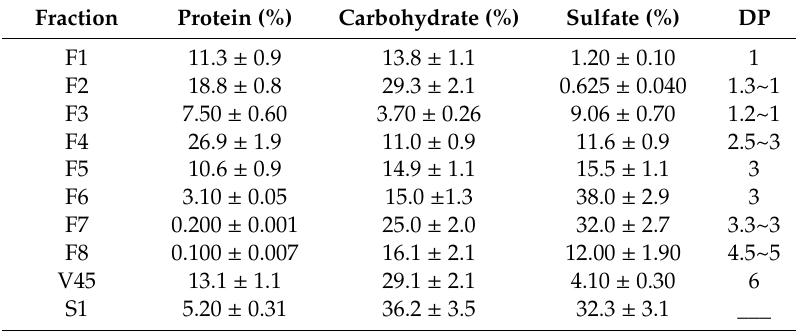
Table 1. Protein, carbohydrate, and sulfate contents together with the degree of polymerization for the parent algal extract, the hydrolysate, and the column e ffl uent